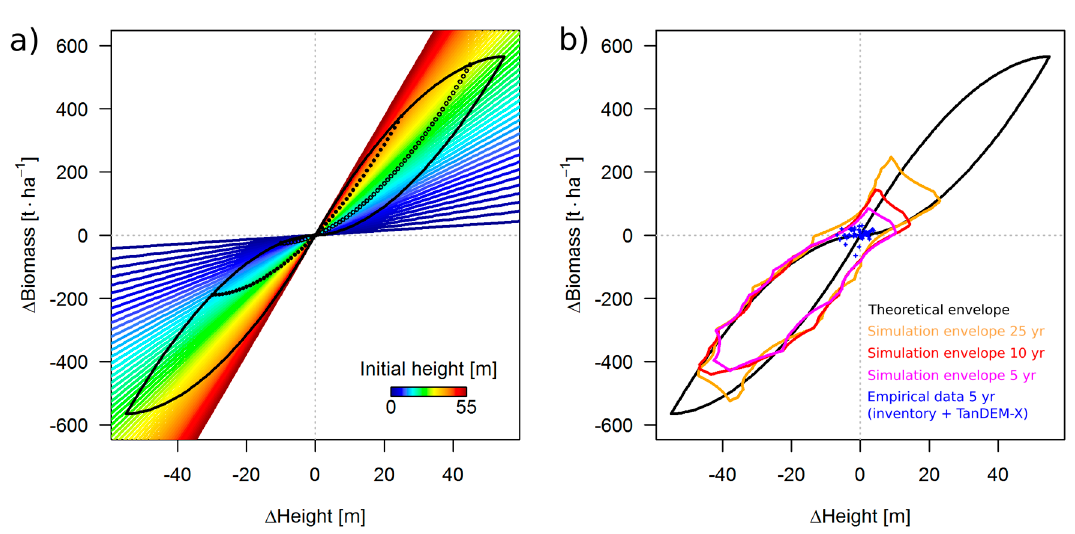
Figure 6. Theoretical considerations on the relationship between height change and biomass change. ( a ) The slopes of the relationship for different initial stand heights. The black envelope covers all possible change combinations if the initial height is restricted to the range of 0–55 m and the height-to-biomass relationship is an exact power law. The (open and closed) circles mark trajectories of different forest stands with a given start height (10 and 30 m); ( b ) the envelopes of simulated data for different time intervals and the empirical data from the Barro Colorado Island (BCI) 50 ha plot.